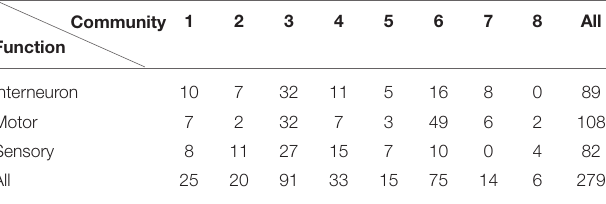
TABLE 3 | Neuron functions of nodes in the dynamical correlation-based partition. Community 1 Function